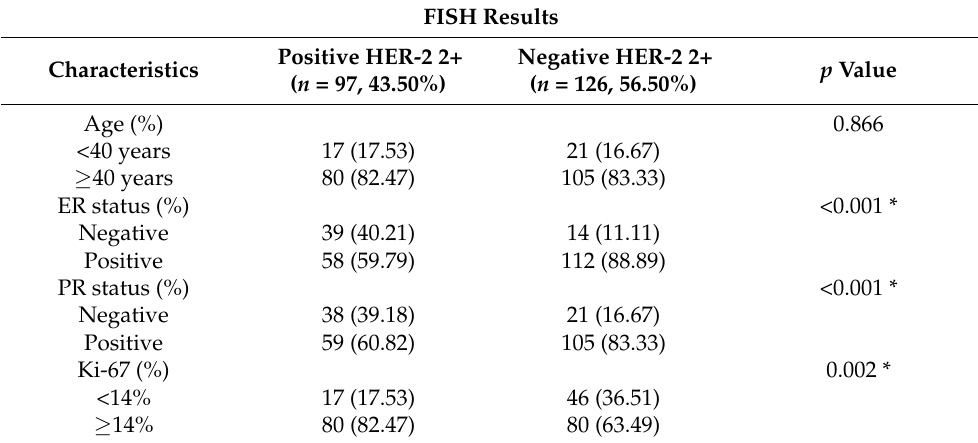
Table 2. Characteristics of 223 patients with HER-2 2+ BC.